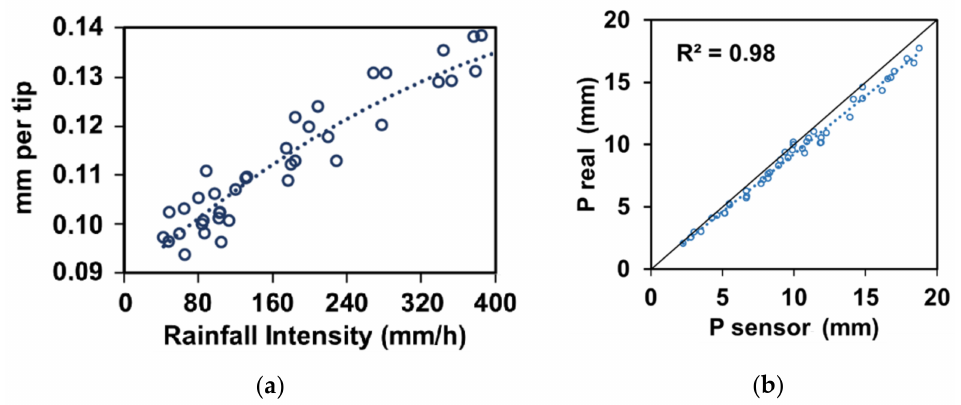
Figure 8. Rain gauge: ( a ) calibration curve and ( b ) R 2 validation